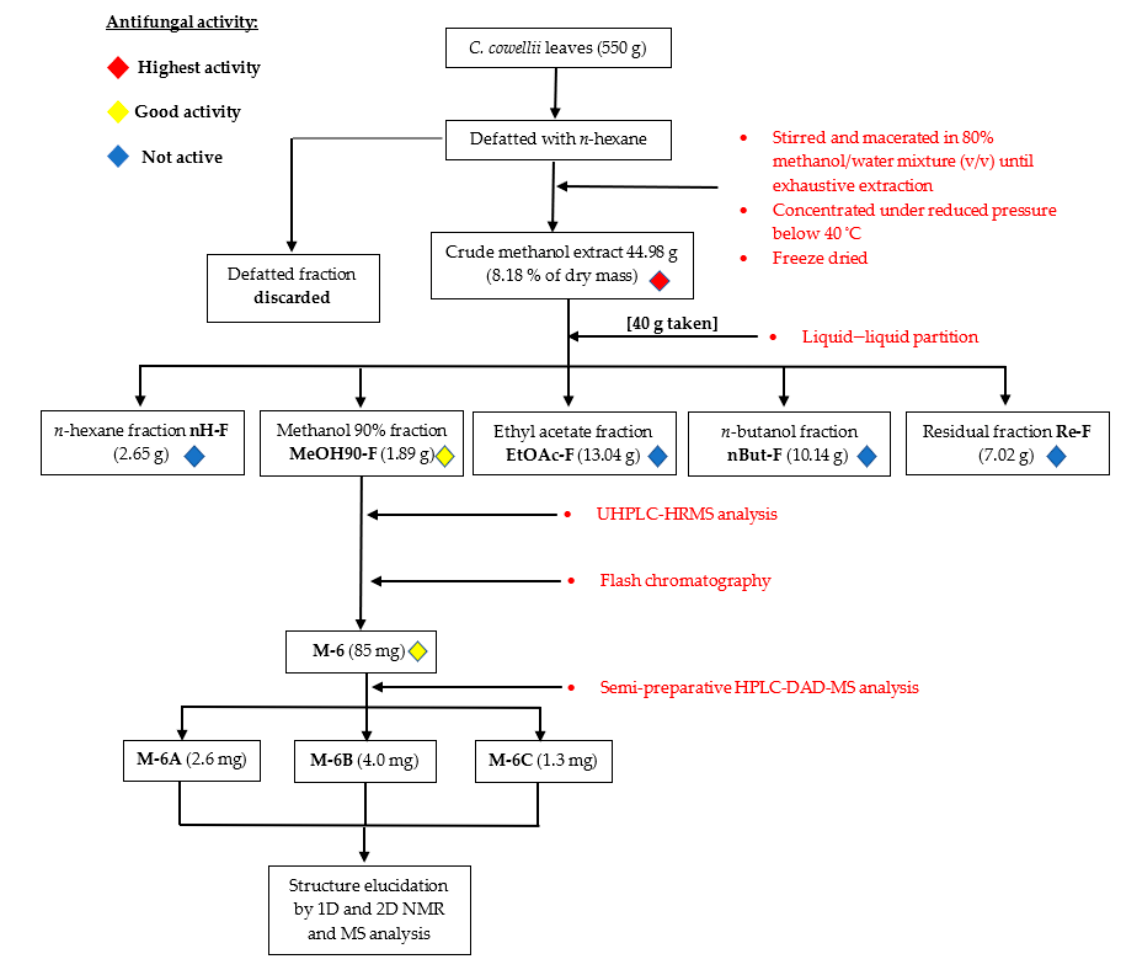
Figure 1. General scheme of the bioassay-guided fractionation performed on the methanolic extract from C. cowellii leaves. Table 1. In vitro antifungal and cytotoxic activity of the total extract and fractions from C. cowellii leaves.